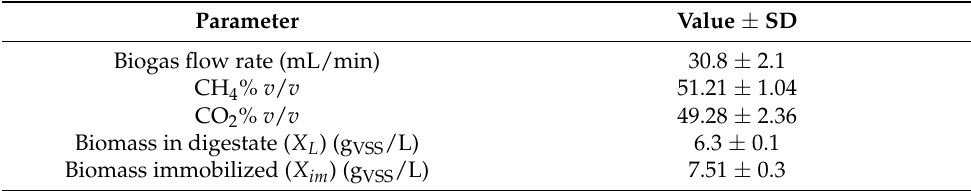
Table 4. Values of the main parameters of the reactor during Anaerobic Digestion.